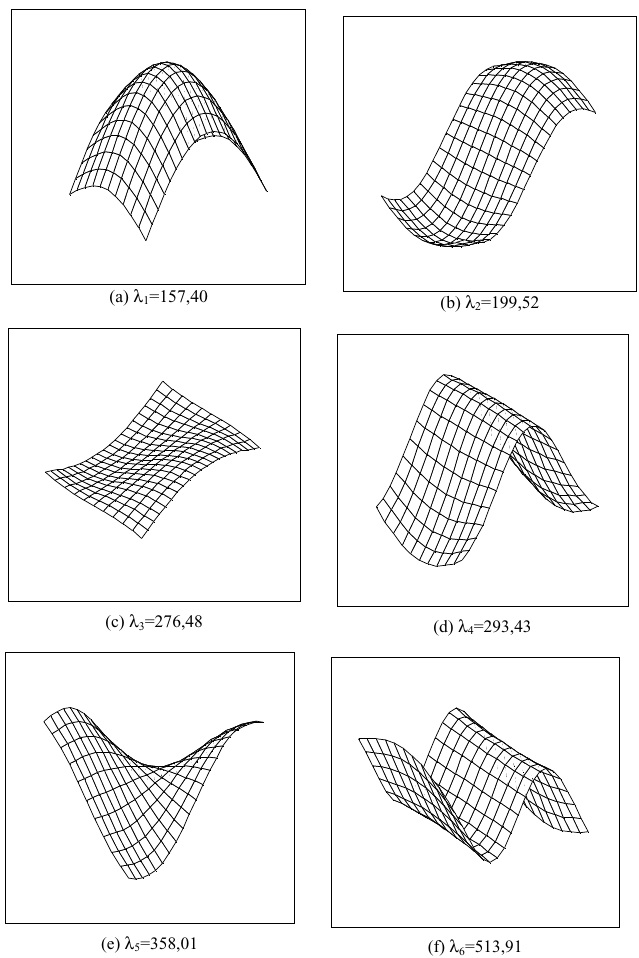
Fig. 8. First six mode shapes of the plate on elastic foundations for γ = 1, H = 5 m, and l y /l x = 2.00. (a) The first mode shape; (b) The second mode shape; (c) The third mode shape; (d) The fourth mode shape; (e) The fifth mode shape; and (f) The sixth mode shape. The decrease in the frequency parameters with increasing l y /l x ratio for a constant value of H and γ gets larger for smaller values of l y /l x